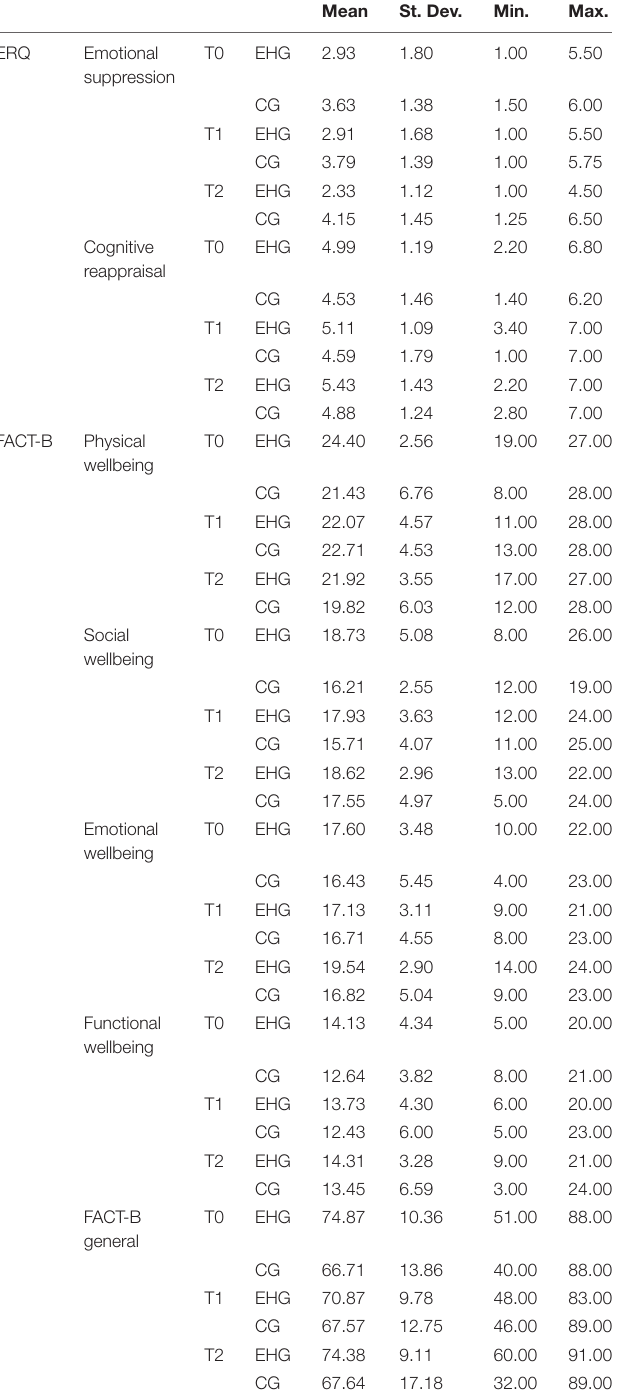
TABLE 1 | Descriptive data for EQR and FACT-B questionnaires. Mean St. Dev. Min.